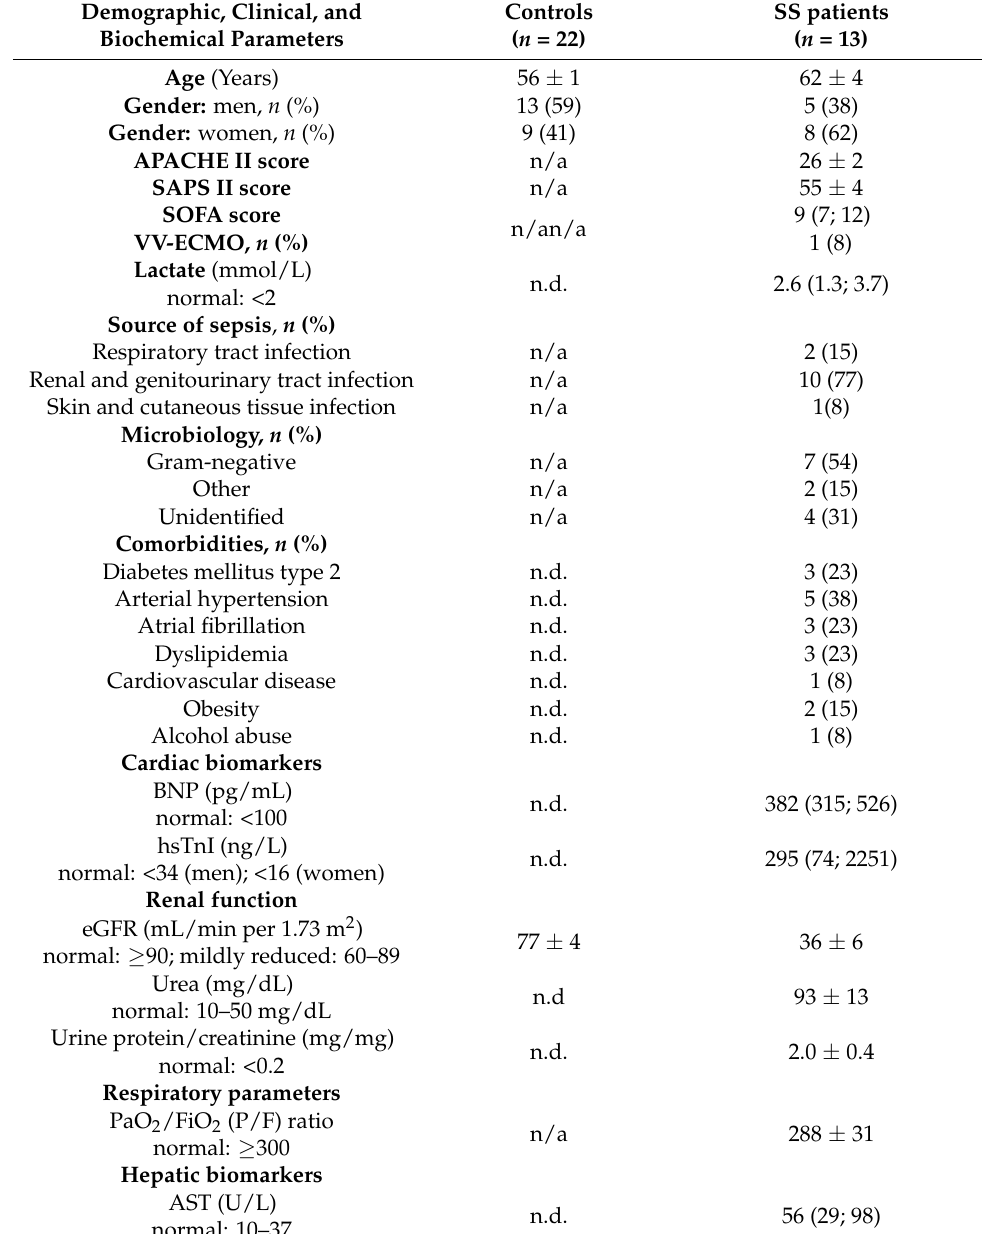
Table 1. Demographic, clinical, and biochemical characteristics at admission and outcomes of study